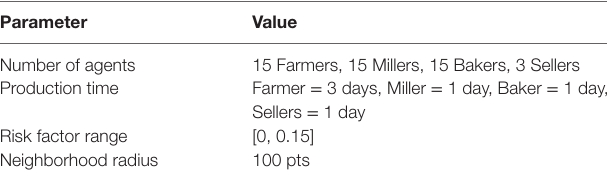
TaBle 4 | initial conditions for experiment #3, case a.